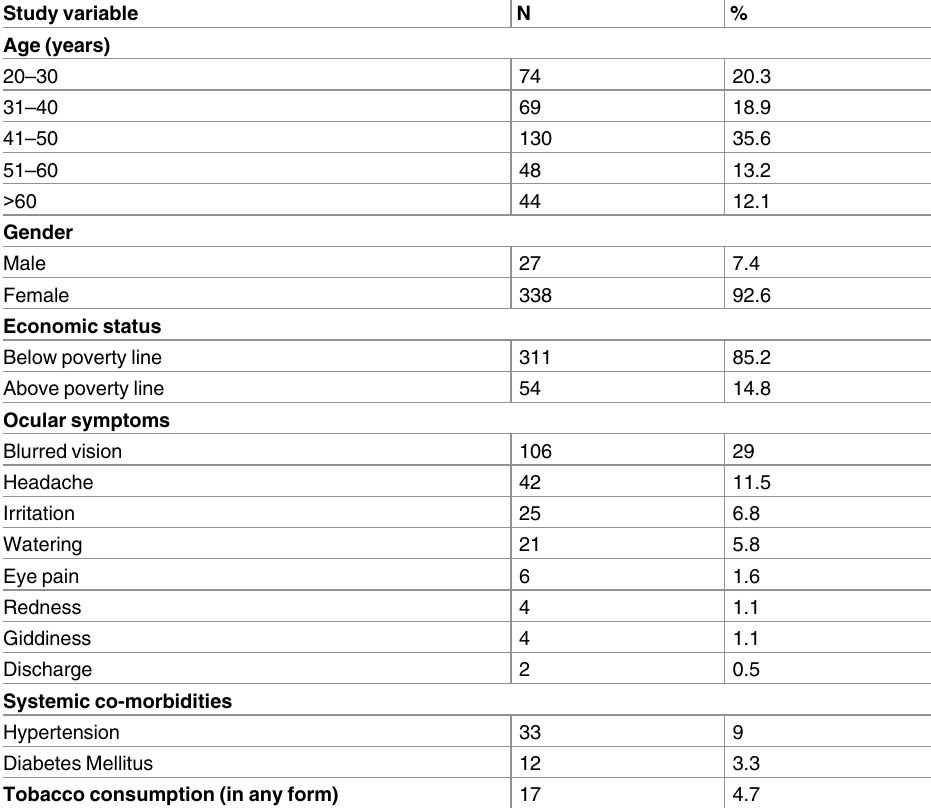
Table 1. Descriptive statistics of beedi rollers in selectedrural areasof Dakshina Kannada district, Karnataka, India, April-Sept 2016 (N = 365). Study variable